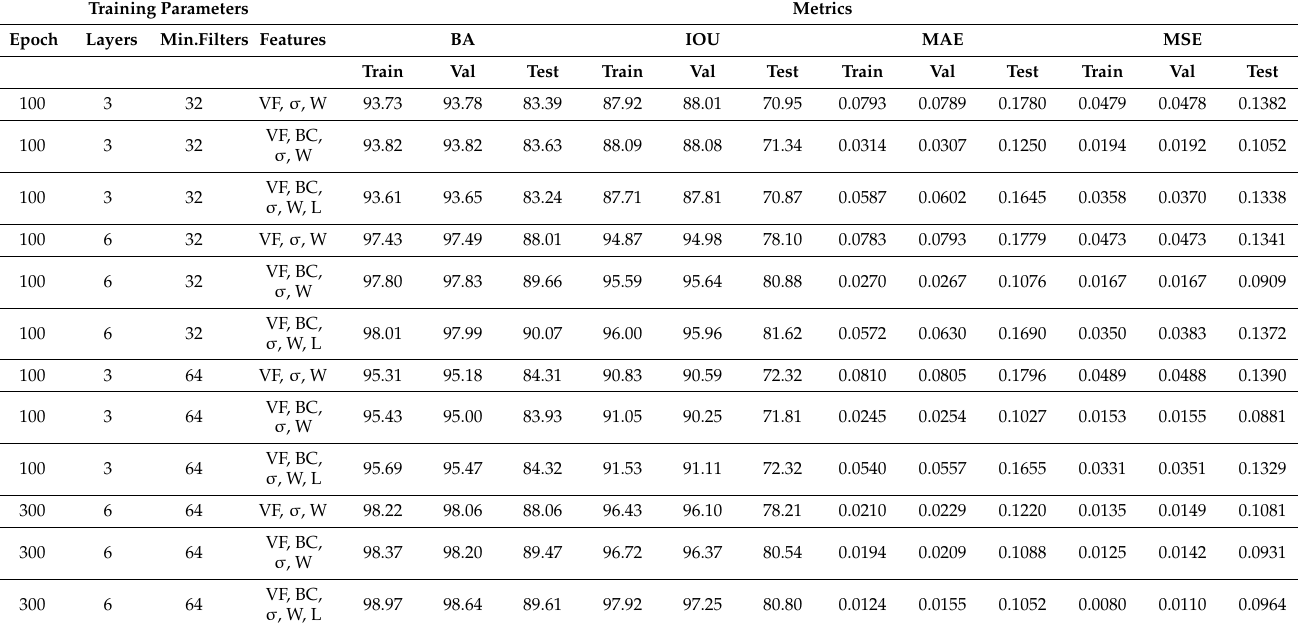
Table 3. Dependency between accuracy and features.